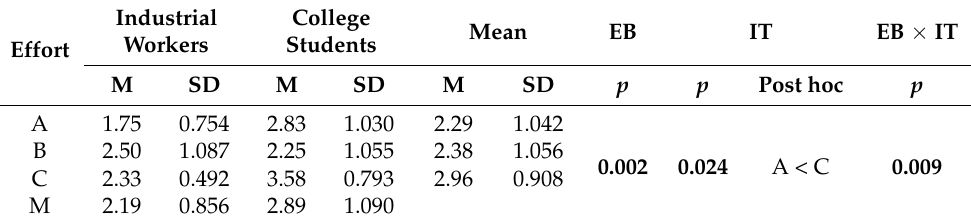
Table 8. Descriptive statistics and two-way ANOVA on the effort by